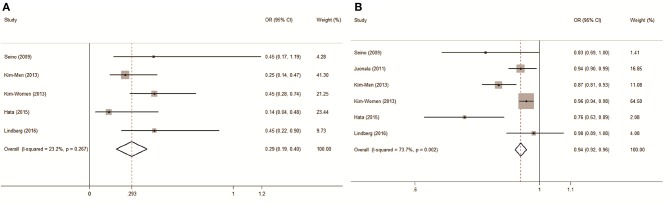
Forest plot on association between circulating adiponectin and metabolic syndrome risk assessed in prospective studies. (A) Pooled OR of MetS compared between groups with highest and lowest ADPQ levels; (B) Pooled OR of MetS followed per 1 ug/ml ADPQ increase. ADPQ, adiponectin; MetS, metabolic syndrome; OR, odds ratio.